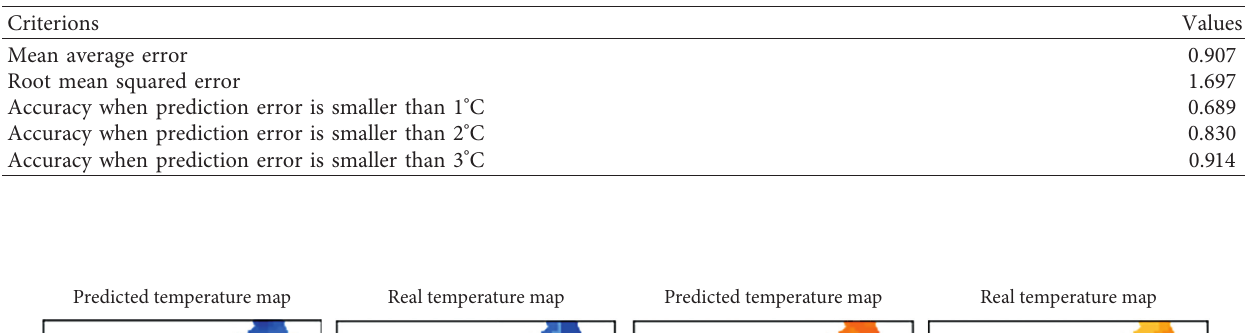
Table 3: Performance of CRNN model.